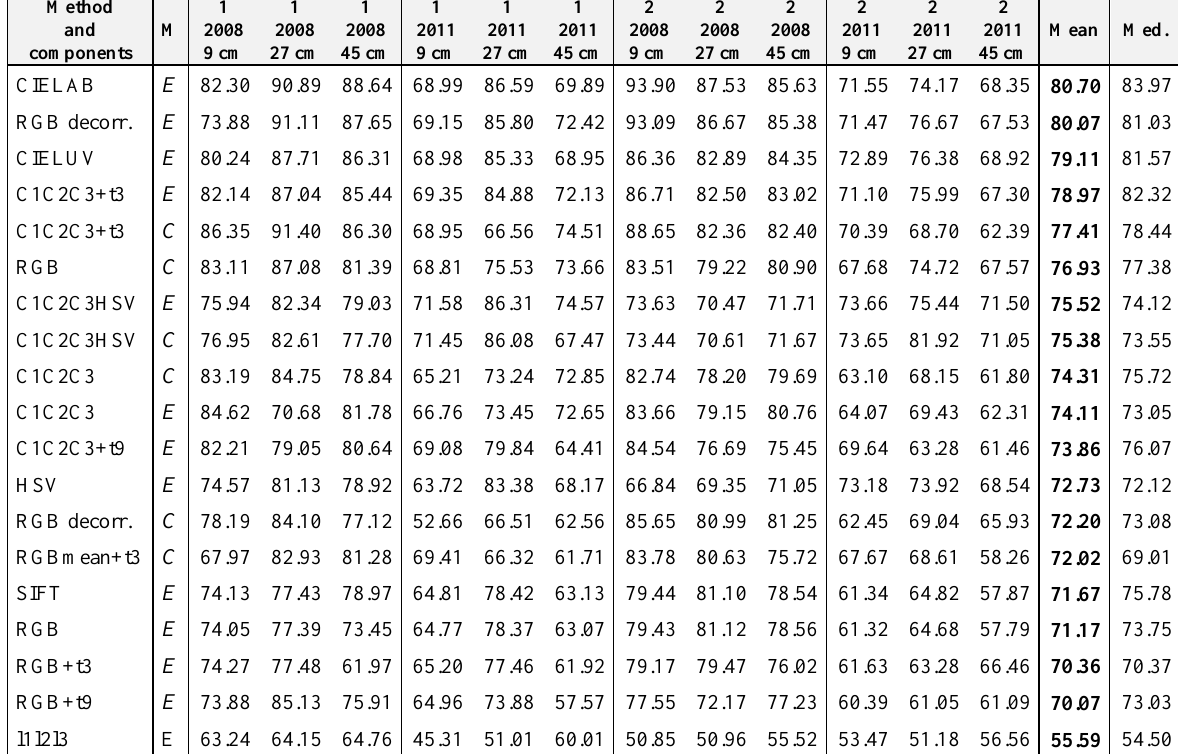
Table 1: Agreement percentages between the various unsupervised K-means classifications of the different pixel components, and the supervised classifications assumed as reference. Column M specifies the metrics (E=Euclidean, C=cosine), Med. the median values, t3 and t9 indicate the window size (3×3 or 9×9 cells) for texture